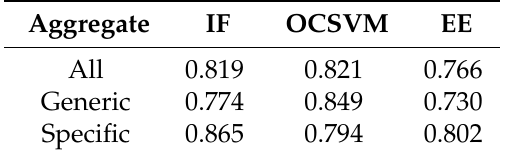
Table 5. Aggregate accuracies for different training